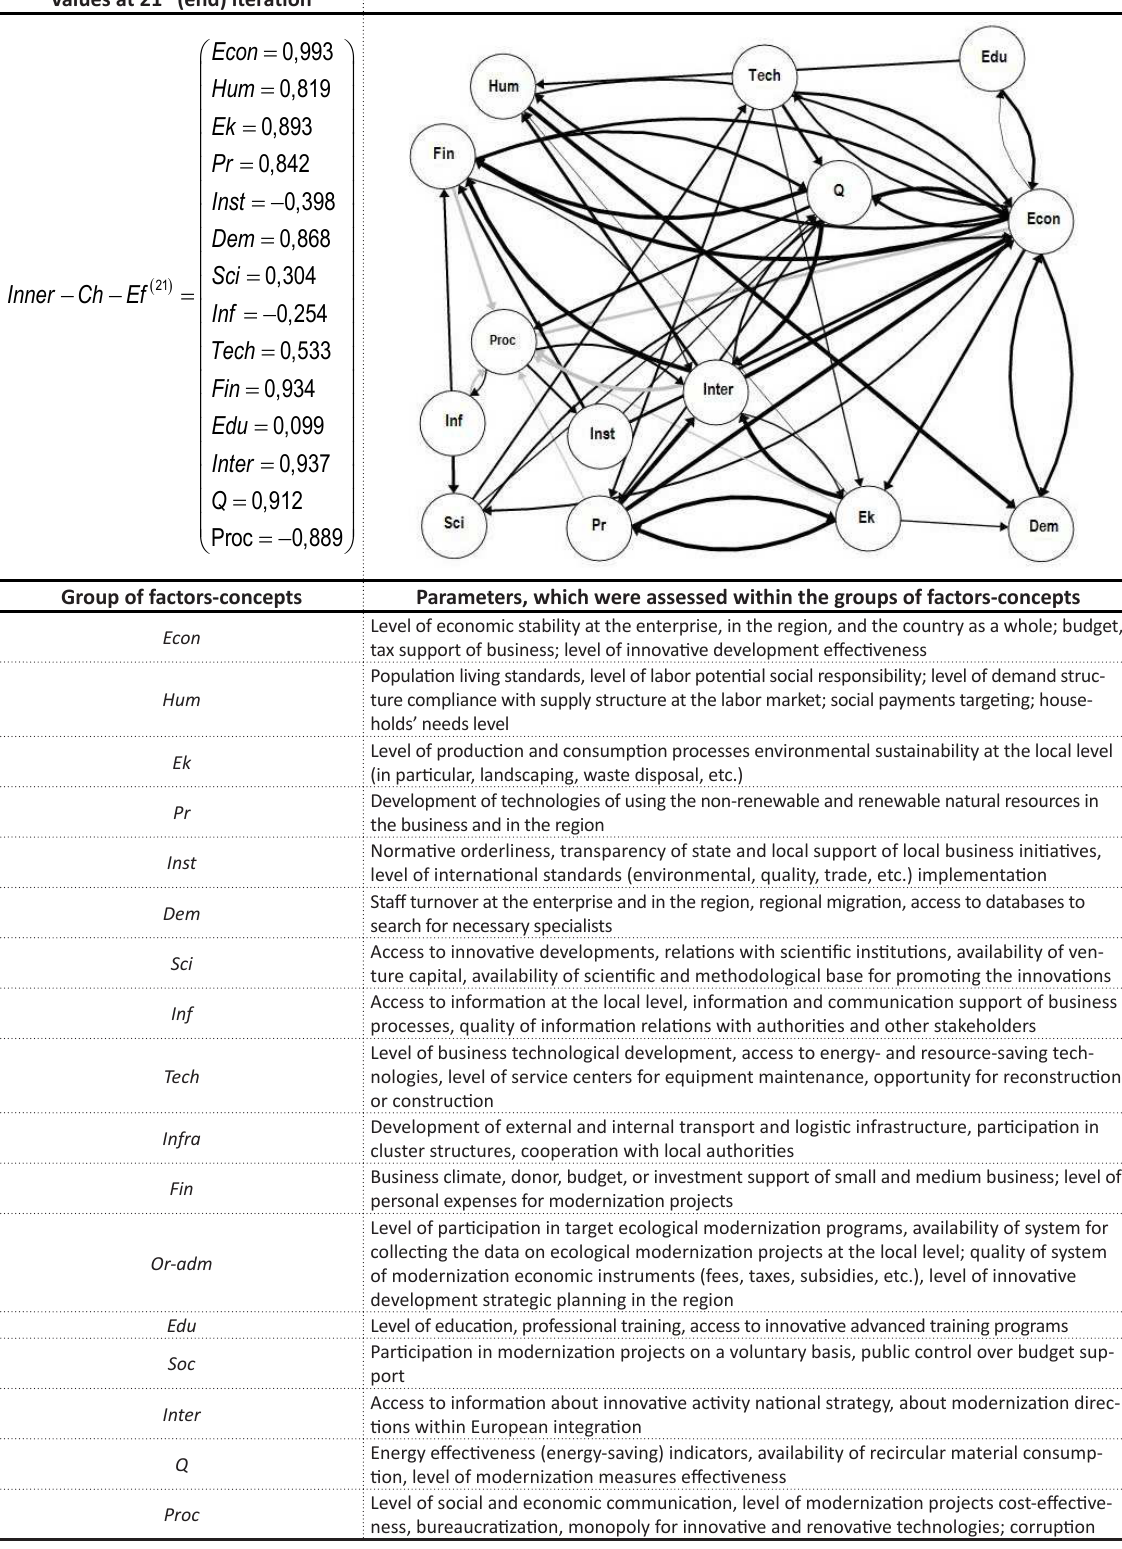
Figure 1. FCM analysis results for defining Inner-Ch-Ef channels for stimulating the ecological modernization changes in the national